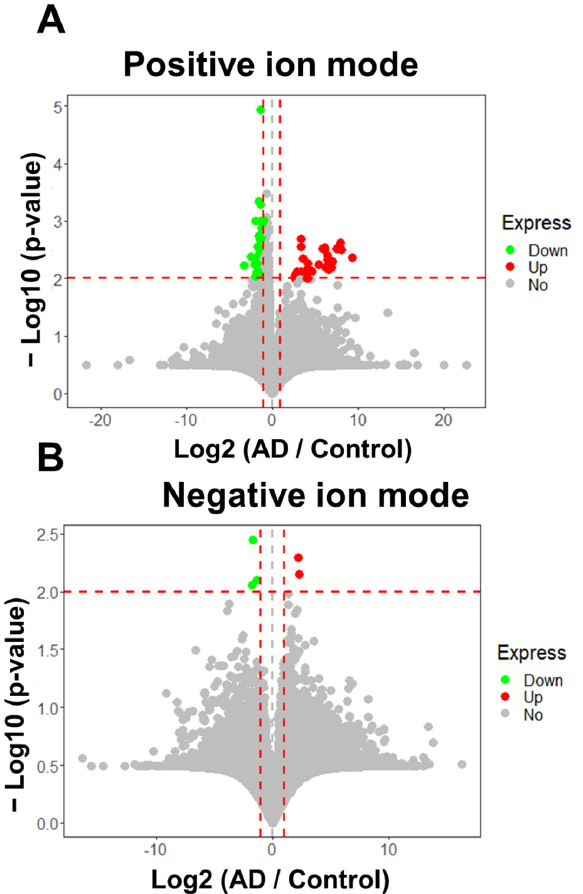
Figure 2. Statistically significant features (AD/Control ≥ 2 or ≤ 0.5, p ≤ 0.01) in the hair between Alzheimer’s disease and controls. ( A ) 67 of 12,353 detected signals were discriminatory features (fold change ≥ 2 or ≤ 0.5, p ≤ 0.01) in positive ion modes. Of these, abundances of 33 signals were increased and 38 signals were decreased in AD group relative to control in positive ion mode. ( B ) 5 of 8821 signals were significant, using the criteria (fold change ≥ 2 or ≤ 0.5, p ≤ 0.01) in negative ion mode. Of those, 2 signals were overexpressed, and 3 signals were under expressed in AD patients relative to control in negative ion mode analysis. The horizontal and the vertical red dashed lines represent the cutoff of − Log10( p -value) and Log2 (AD / Control) for 2 and ≧ 1 or ≦ − 1, respectively. To find the discriminatory features with similar expression patterns in the 48 hair samples, unsupervised clustering of the detected normalized intensity of 25 annotated metabolites was performed by two-way hierarchical cluster analysis (HCA) based on Pearson’s correlation. Figure 3 shows a heatmap with z score values, which indicate the number of standard deviations above or below the average value for each raw value, where the relative abundance of metabolites detected in each sample is represented using a color scale. Each row represents a discriminatory metabolite, and each column represents a biological sample. The z score value of each feature is plotted on a red-blue color scale. A red color indicates that the z score value is greater than 0, and a blue color indicates